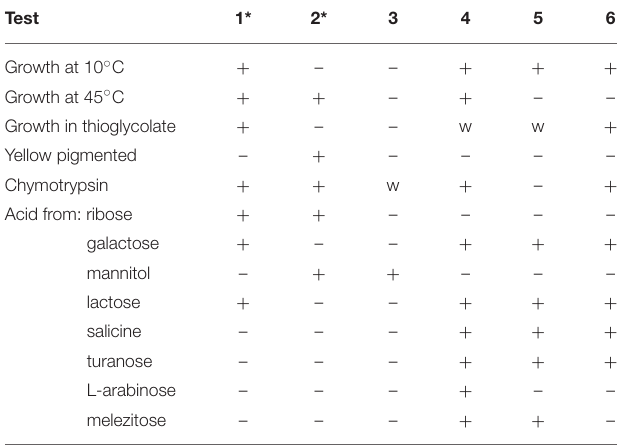
TABLE 4 | Phenotypic characteristics that differentiate novel macrococci from phenotypically related Macrococcus caseolyticus subsp. caseolyticus subsp. nov. and Macrococcus canis